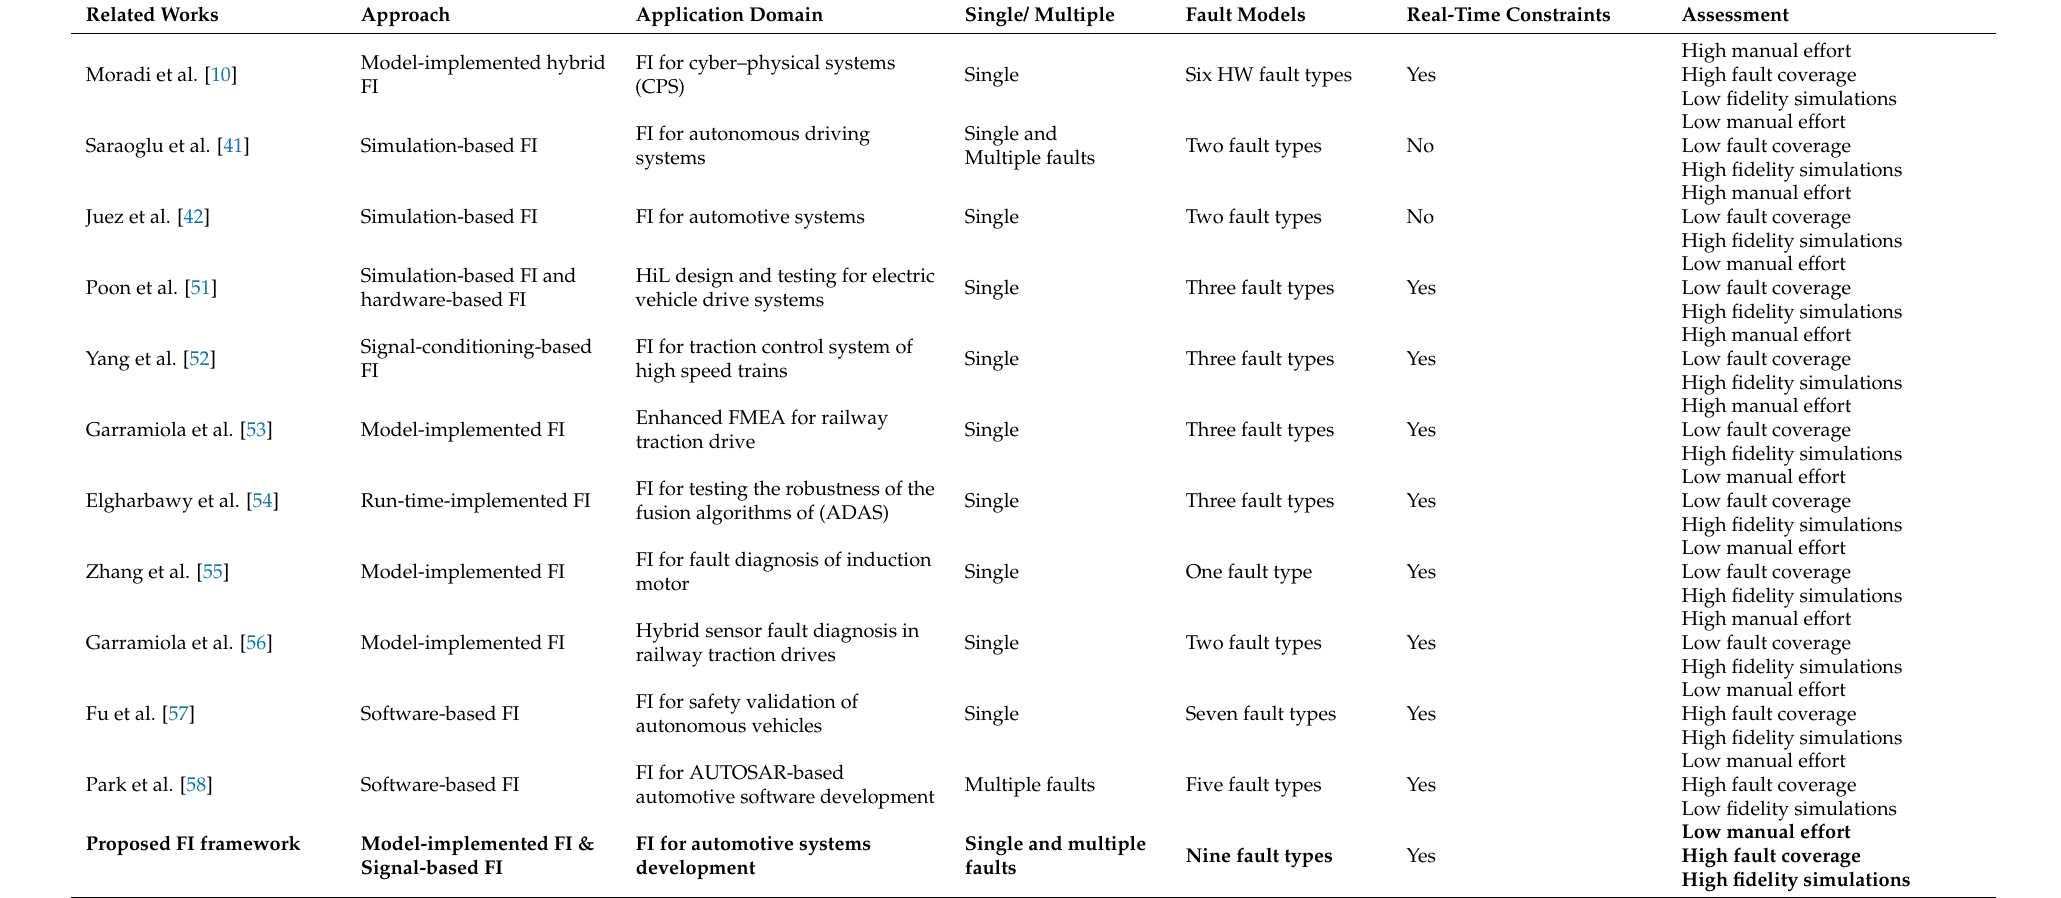
Table 1. Overview of the related